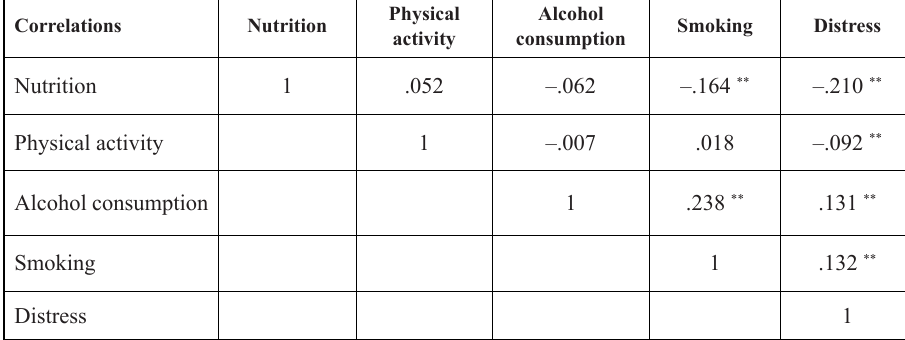
Table 1. Pearson correla- tion coefficients between health related behaviour and distress